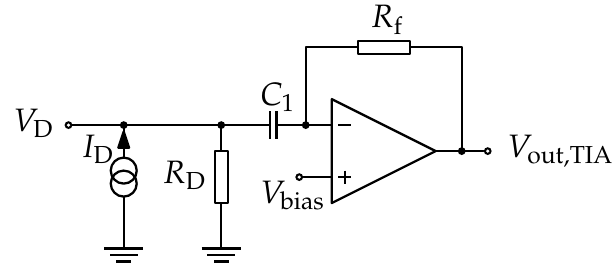
Figure 10. Schematic of the TIA